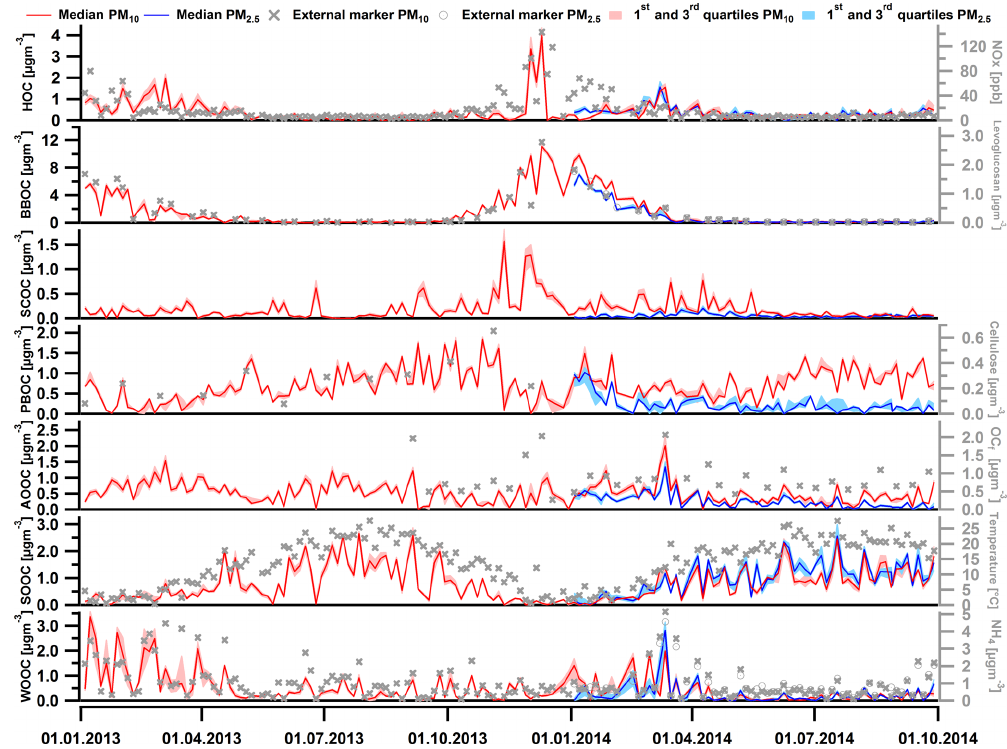
Figure 6. Factor (in red for PM 10 and blue for PM 2 . 5 ) and external marker (in grey markers) time series for the two size fractions: HOC and NO x , BBOC and levoglucosan, SCOC, PBOC and cellulose, AOOC and OC f , SOOC and temperature, and WOOC and NH + here, different from Fig. 5, the factors are quantified according to their carbon mass concentration, with HOC, BBOC, SCOC, PBOC, AOOC, SOOC, and WOOC referring to hydrocarbon-like organic carbon (OC), biomass burning OC, sulfur-containing OC, primary biological OC, anthropogenic oxygenated OC, summer oxygenated OC, and winter oxygenated OC,